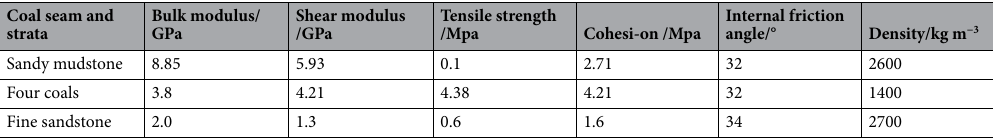
Table 2. Physical and mechanical properties of rock